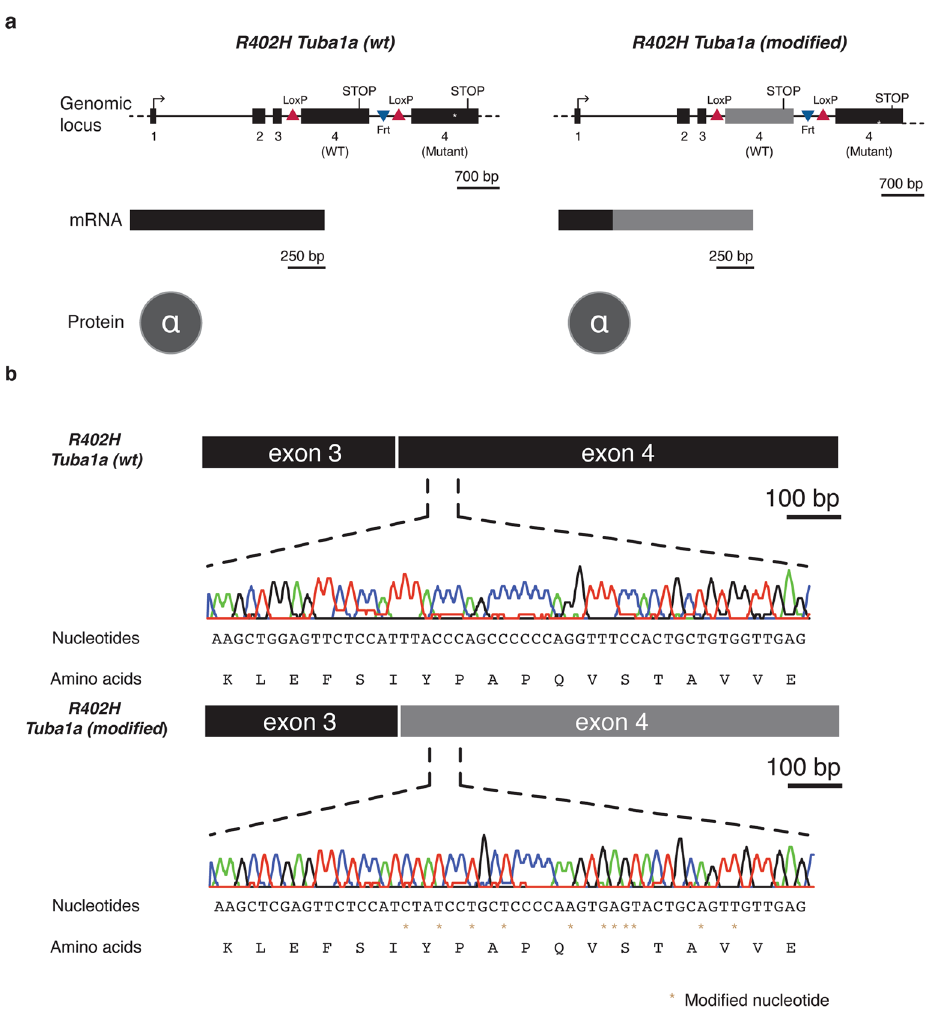
Figure 1. Two R402H Tuba1a mouse lines expressing either wild-type or a modified version of exon 4. ( a ) Schematic representation of the genomic locus in both R402H Tuba1a conditional mouse lines. In both cases, exon 4 was flanked by LoxP sites to enable the expression of R402H mutant Tuba1a , in the presence of Cre recombinase. In the R402H Tuba1a (modified) line, the codon sequence was altered (in grey). This modification results in a different mRNA sequence compared to the R402H Tuba1a (wt) line however, on the protein level, both TUBA1A molecules share the same sequence. ( b ) Sequencing traces from the R402H Tuba1a (wt) and R402H Tuba1a (modified) lines show the synonymous variations introduced (gold